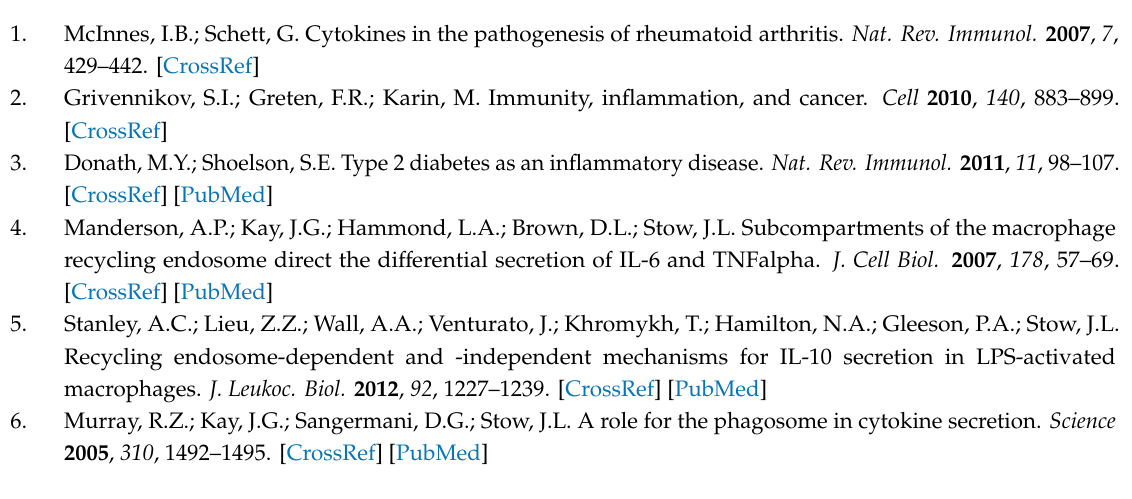
Figure S1: CDKI-73 alters the number and morphology of Rab11 endosomes, Figure S2: CDKI-73 exhibits low cytotoxicity on fat body cells, Figure S2: CDKI-73 reduced amount of Drs at the cell surface, Figure S3: IL-6 and TNF α co-localise with Rab11 endosomes in LPS-stimulated THP-1